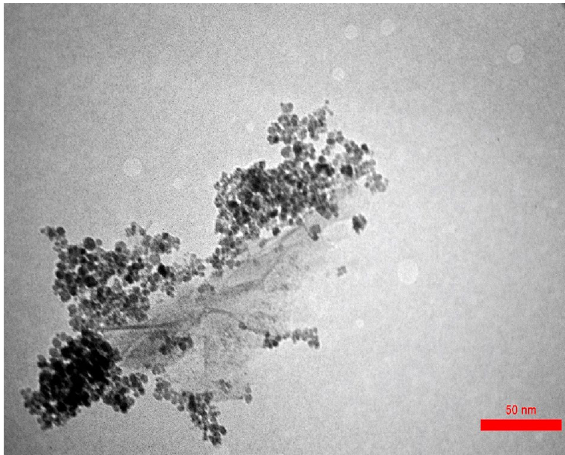
Figure 11. TEM image of the Pip@MGO.